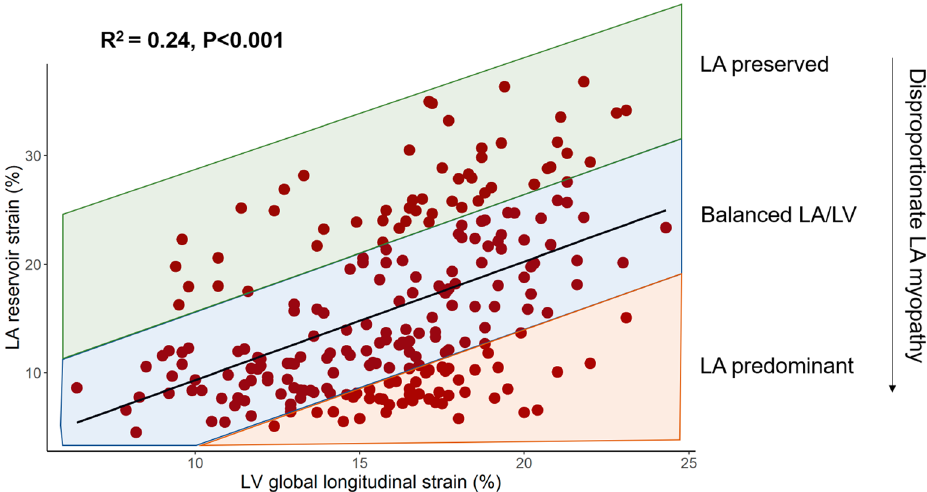
Figure 2. Association of LV global longitudinal strain with LA reservoir strain. Degree of LA myopathy (i.e. disproportionate LA myopathy) was defined as studentized residual values derived from the linear regression model of LV GLS and LA reservoir strain. Lower residual values thus correspond to disproportionately greater LA myopathy compared with LV myopathy. GLS global longitudinal strain, LA left atrial, LV left